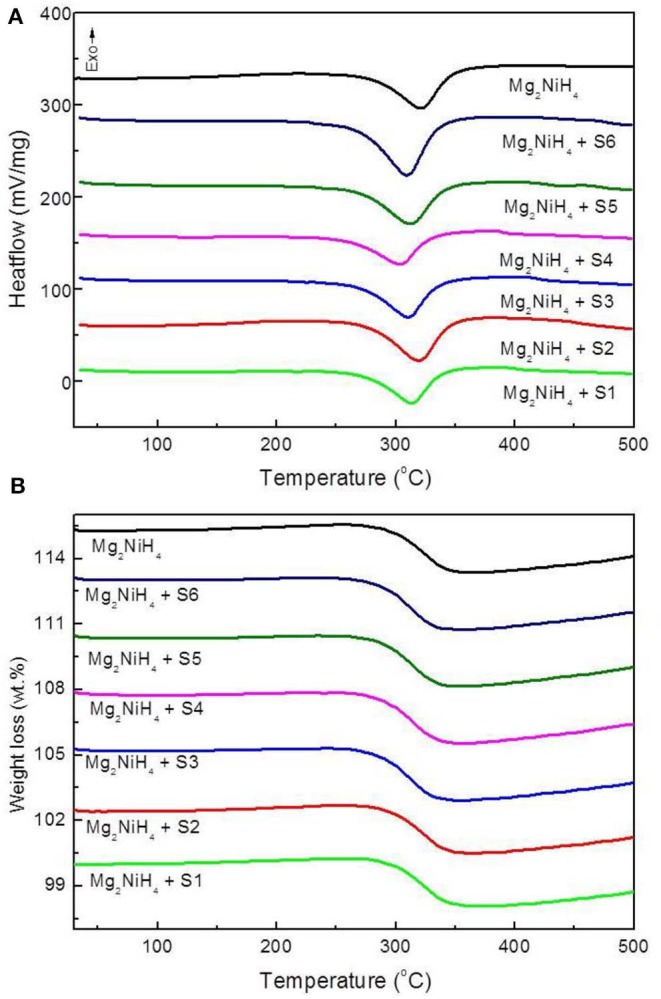
(A) DSC and (B) TG curves of the ball-milled Mg2NiH4-CeH2.73/CeO2 composites materials, at a heating rate of 20 K/min.